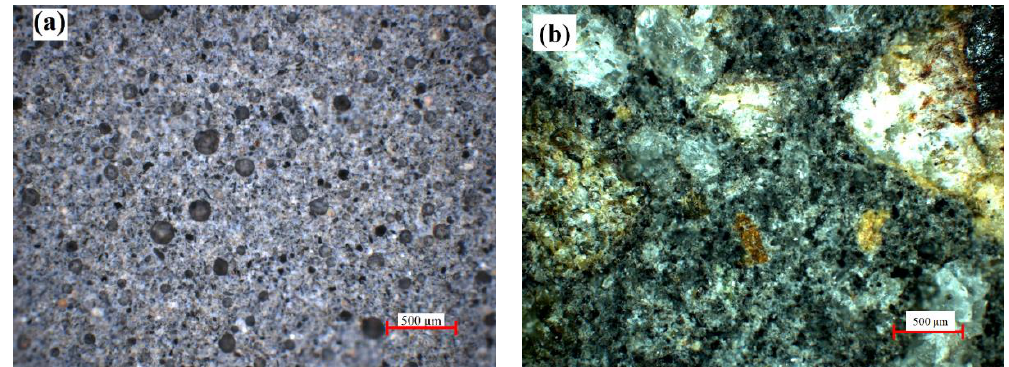
Figure 6. Optical micrographs of: ( a ) sample 100FA; ( b ) sample 30FA_70S.